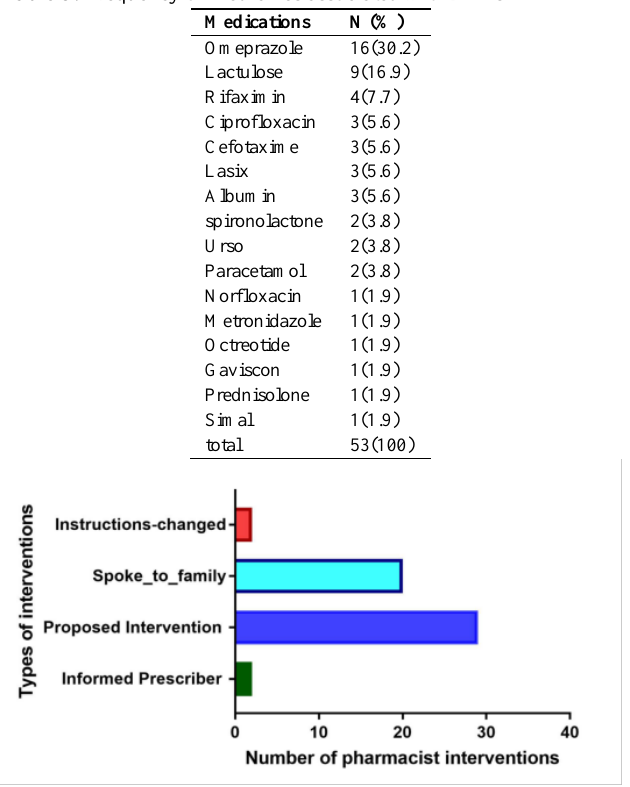
Figure 1: The types and number of pharmacist interventions to address drug-related problems